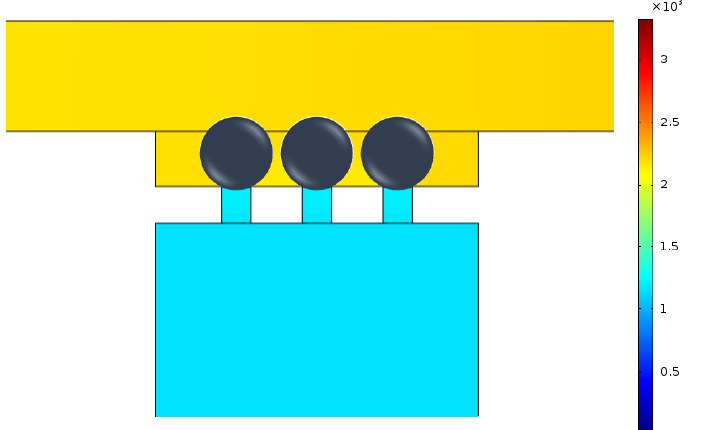
Figure 4. Pressure distribution around the micropipette aspiration